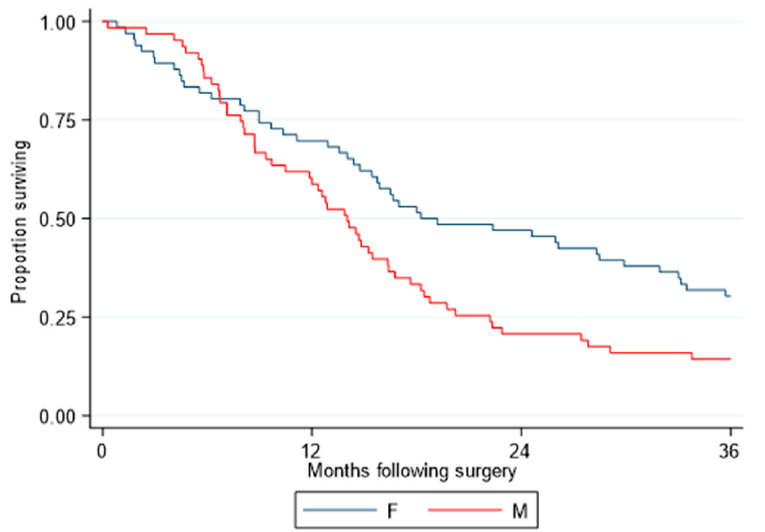
Figure 2. Survival analysis of the patients with MPM included in the selected cohort according to sex. Kaplan-Meier curves of overall survival between the two sexes in the selected datasets ( n = 129). Red and blue curves represent male and female, respectively. Overall survival was calculated from date of surgery. Survival curves were truncated at 36 months.